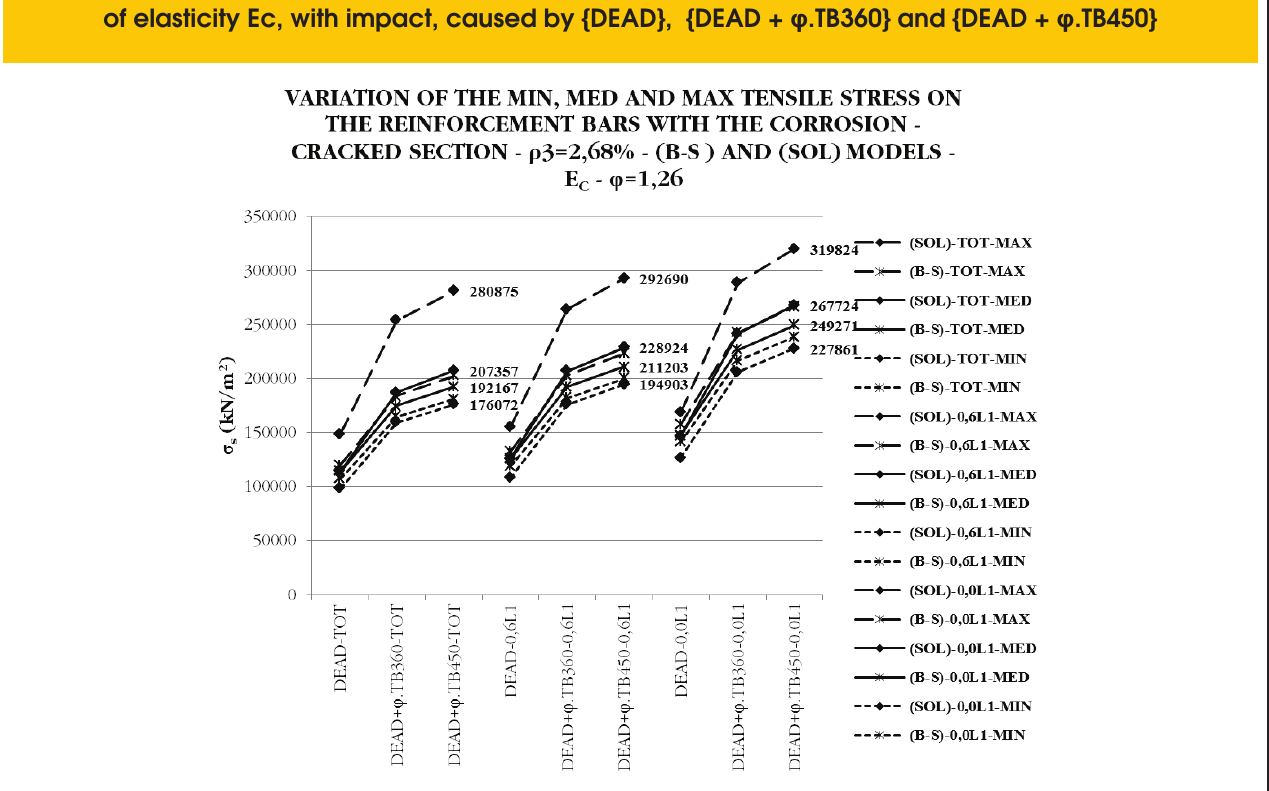
Figure 25 – Variation of minimum, medium and maximum tensile stress in the reinforcement bars with the reinforcement corrosion ( ρ 3=2,68%), for (B-S) and (SOL) models, in cracked section, modulus of elasticity Ec, with impact, caused by {DEAD}, {DEAD + φ .TB360} and {DEAD + φ